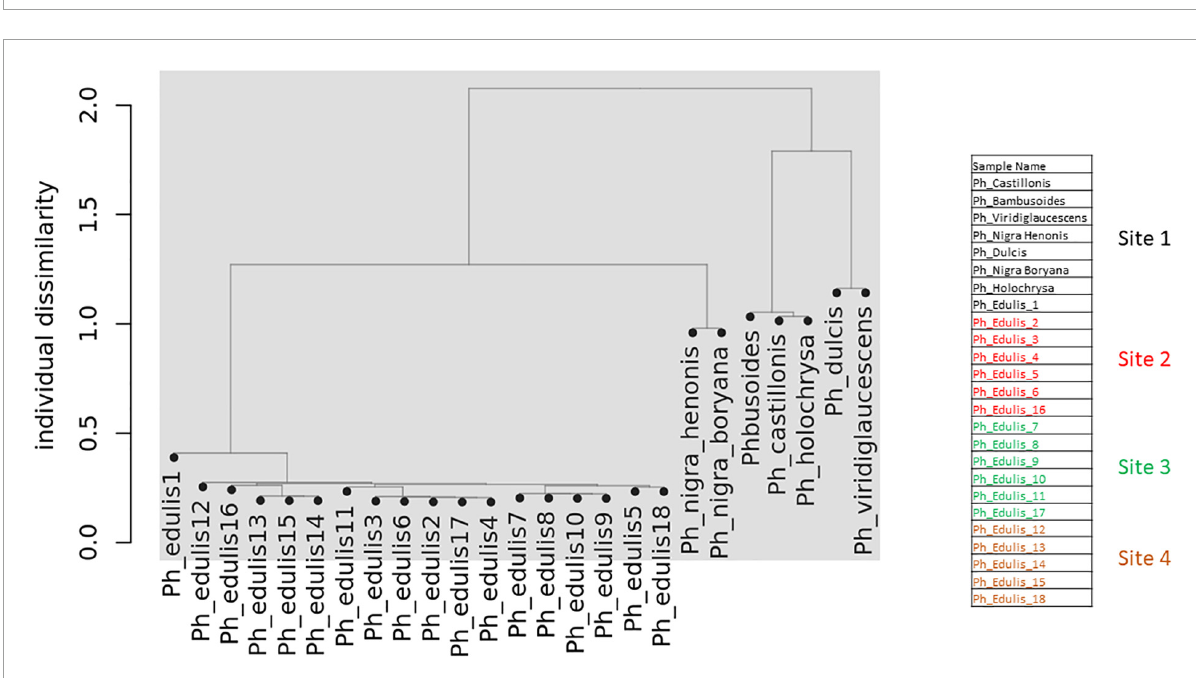
FIGURE4 Dendrogram based on dissimilarity matrix of Euclidean distances from SNP